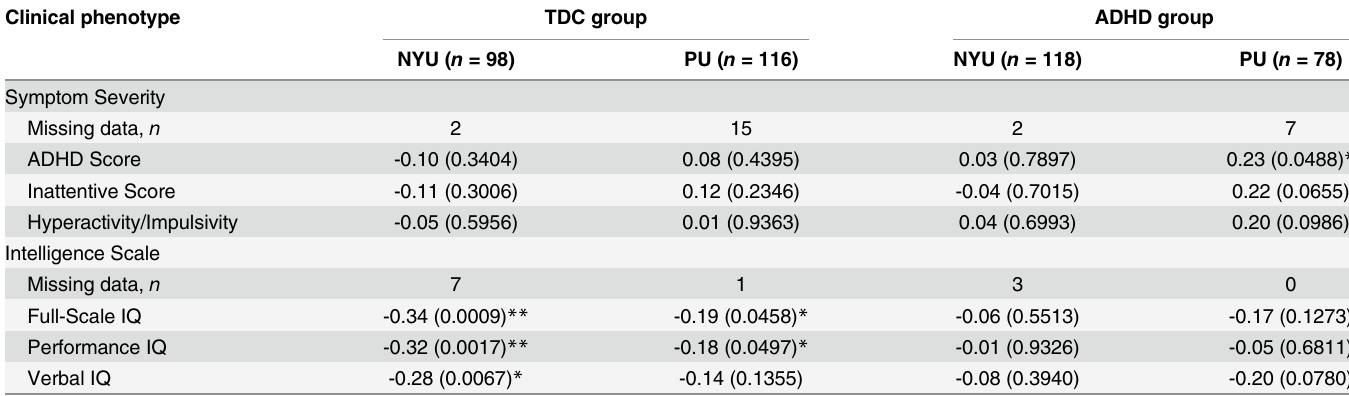
Table 2. Correlations between values of the filter function and clinical phenotypes (symptom severity and